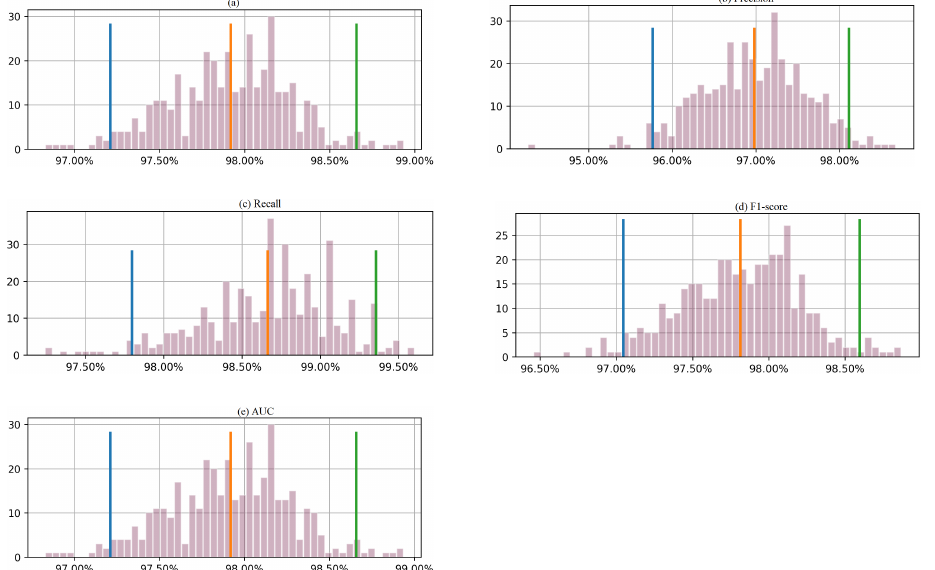
Figure 7. Histogram of 400 bootstrapped outcomes with a 95% confidence interval for each evaluation metric ( a ) accuracy, ( b ) precision, ( c ) recall, ( d ) F1-score, and ( e ) AUC, calculated from the testing Dataset 2.